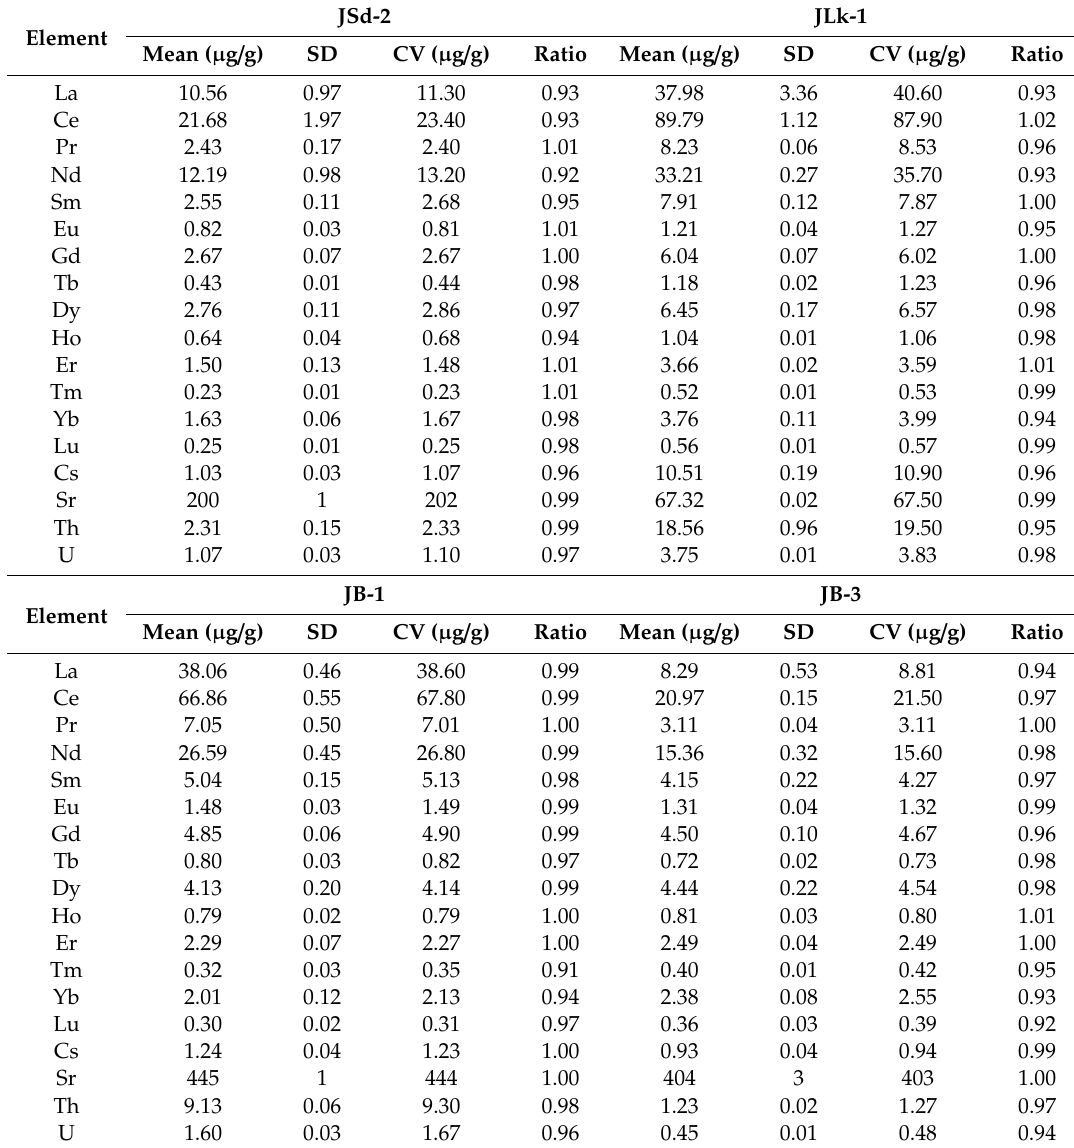
Table 1. Analytical results obtained by ICP-MS for JSd-2, JLk-1, JB-1 and JB-3 in the present study and their comparison with certified values